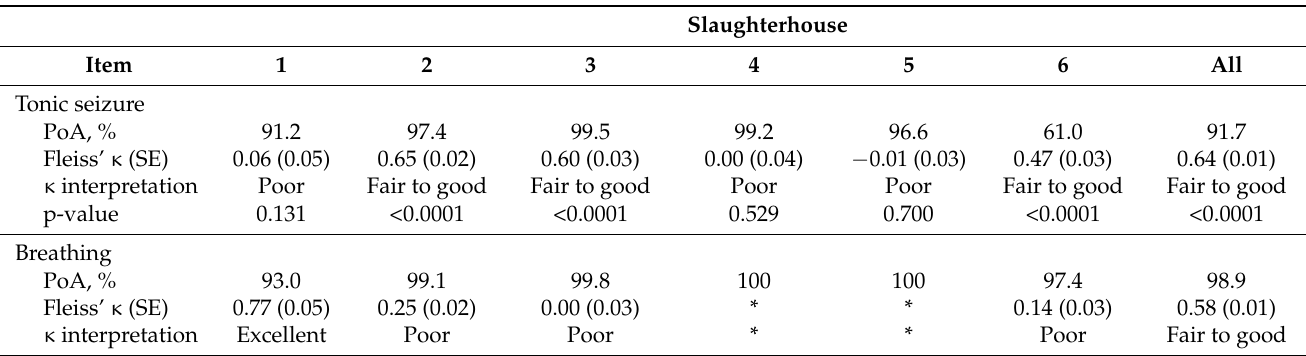
Table 6. Inter-observer proportion of agreement (PoA), Fleiss’ kappa coefficient ( κ ) and interpretation and standard error (SE) of the animal-based indicators for the state of consciousness before bleeding, according to the slaughterhouse